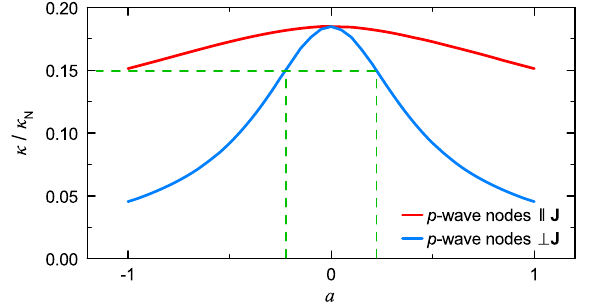
FIG. 5. The calculated thermal conductivity as a function of the relative amplitude a of the p -wave component for j Δ d j þ ia j Δ p j pairing symmetry without normalization for two orientations of the p -wave component d 1 with respect to the heat current J depicted in Figs. 4(a) and 4(b) of the main text. The nodes of the p -wave component are either perpendicular to J [Fig. 4(a)] or parallel to it [Fig. 4(b)]. The electron mean-free path l ¼ 10 ξ , where ξ is the superconducting coherence length, T ¼ 0 . 05 T c , and H ¼ 0 . 3 H c 2 , where H c 2 is the orbital upper critical field. The reduction of κ is much stronger when the p -wave antinode is along the heat current ( p -wave nodes ⊥ J ) because the p -wave antinode gaps the d -wave nodal quasiparticles with momenta along the heat current J . In contrast, when the p -wave antinode is perpendicular to J ( p -wave nodes ∥ J ), the p -wave antinode only gaps quasiparticles with momenta perpendicular to the heat current, resulting in a much smaller effect. The thermal transport in a d -wave superconductor is therefore dominated by the quasiparticles in the nodes that are along the heat